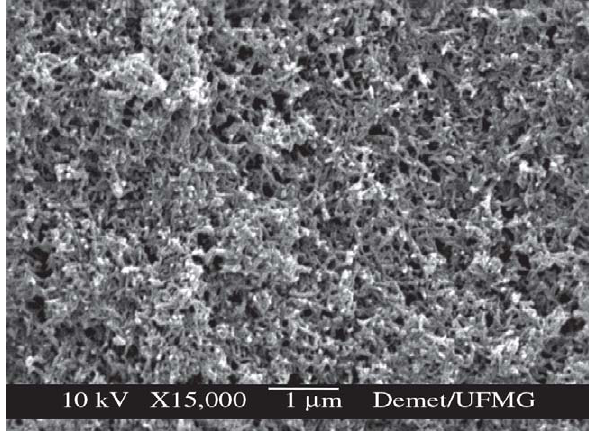
Figure 3. SEM micrograph of as-precipitated HA in a R2 mixture.